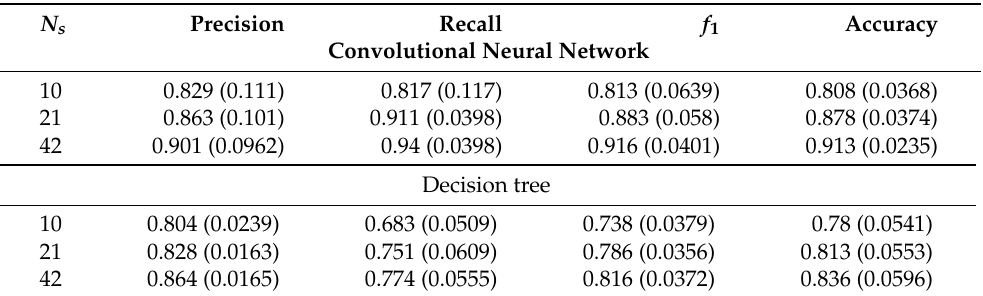
Figure 15. Results for anomaly classification: cnn—convolutional-neural-network-based anomaly classification; dt—decision-tree-based anomaly classification. Numbers below represent the time window length, N s . ( a ) Five-fold cross validation results. ( b ) Leave-one-out validation results. Table 2. Comparison of five-fold cross validation results for deep-learning-based anomaly classifica- tion using all features as input and tree-based